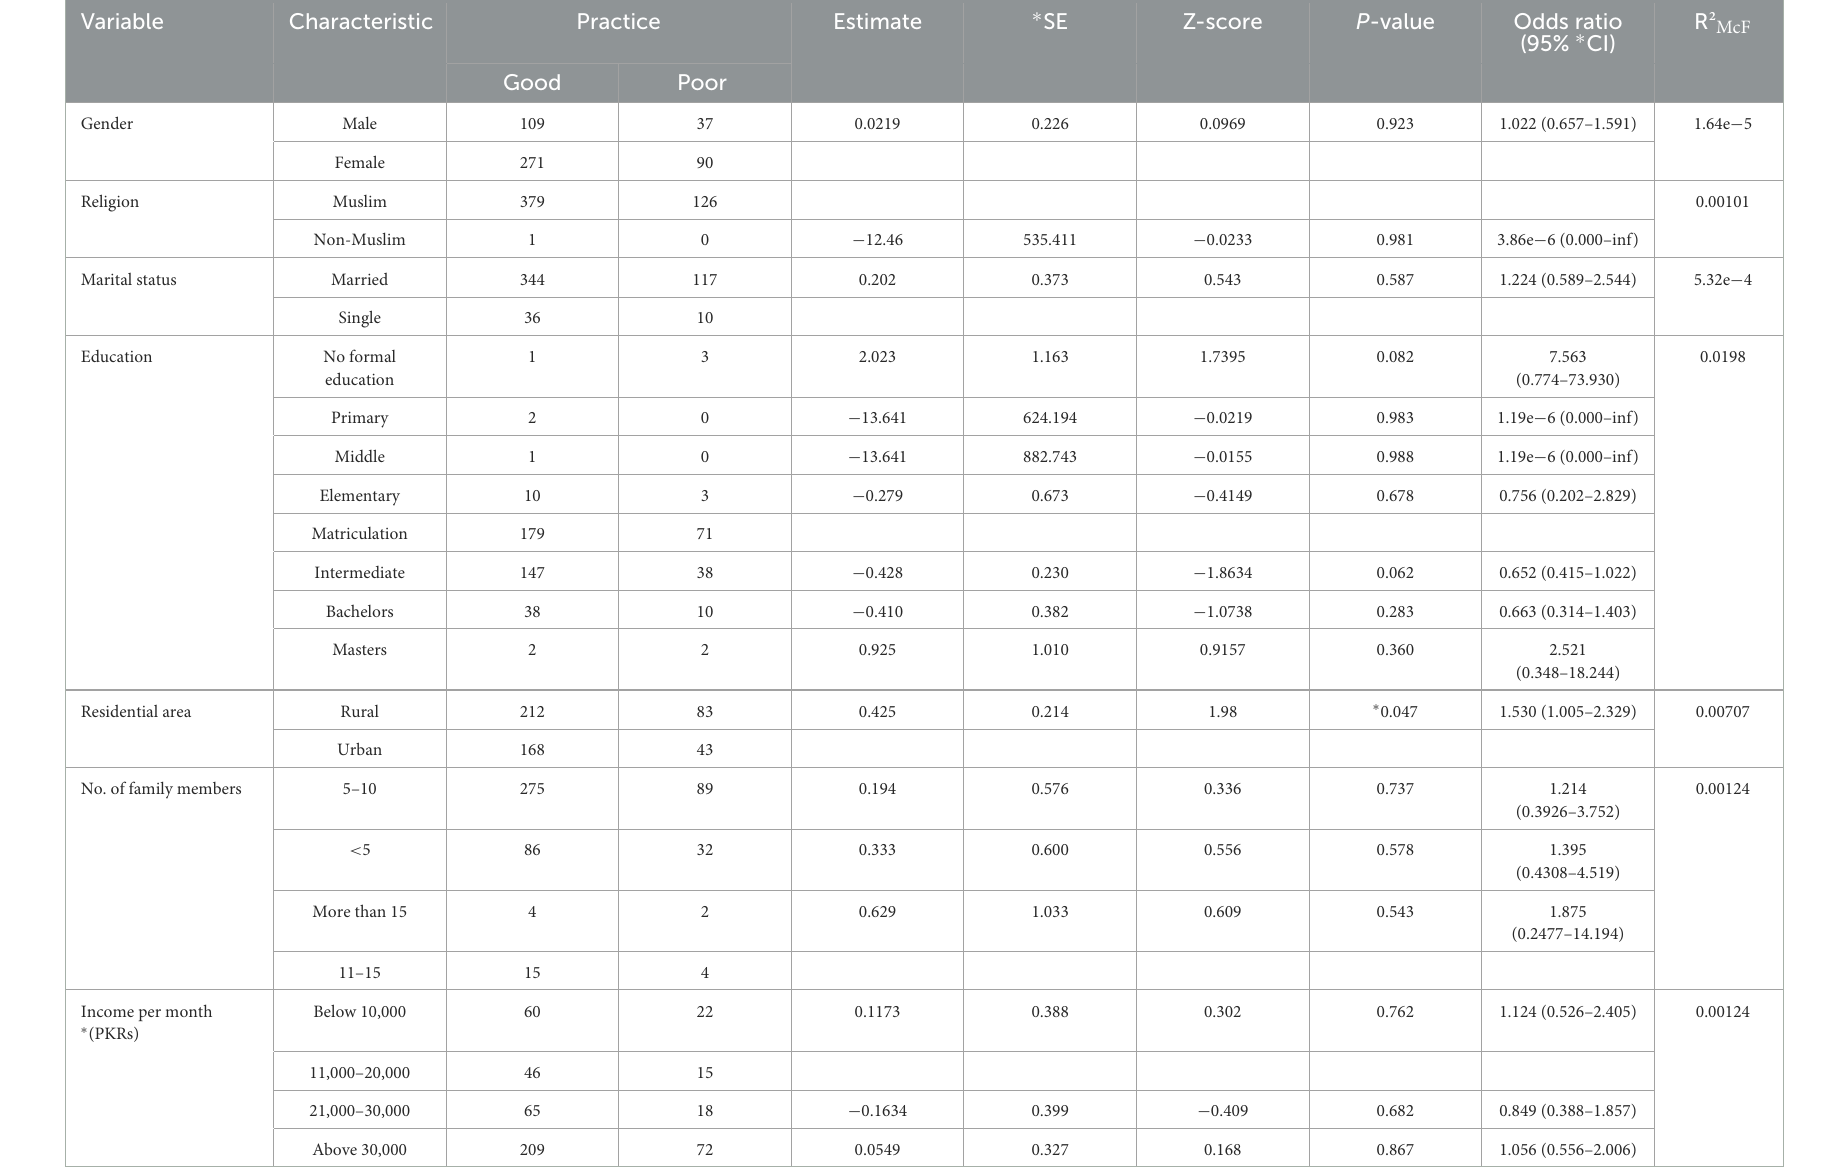
TABLE 8 Associations between participants’ practices and socio-demographic characteristics. Variable